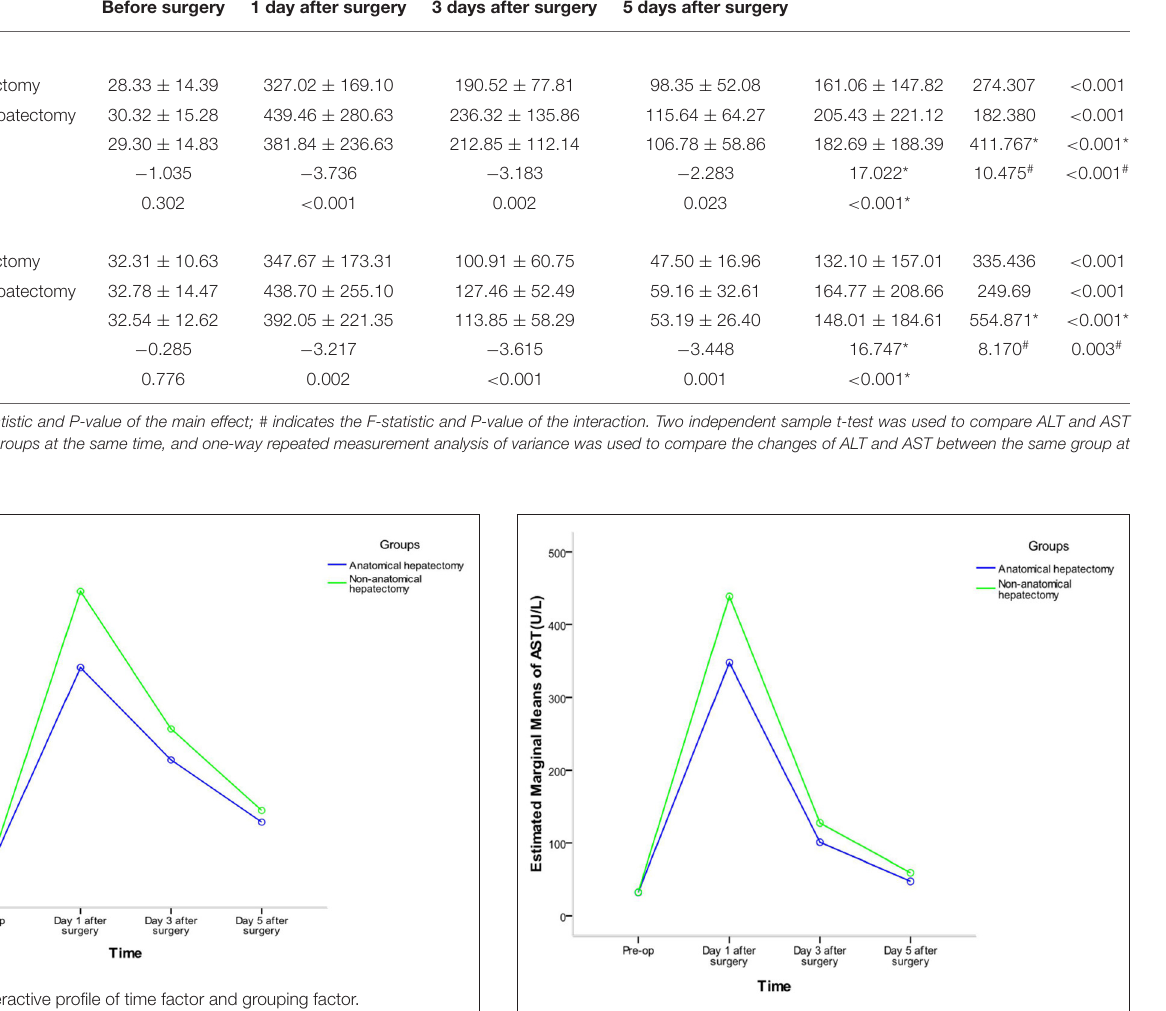
(AST) of the two groups at different times showed that there were significant differences in ALT before and after surgery in the whole sample ( F = 411.767, P < 0.001) and in each group (anatomic hepatectomy group: F = 274.307, P < 0.001; non-anatomic hepatectomy group: F = 182.380, P < 0.001). The trend of ALT in the two groups was the same: ALT was the lowest before surgery, peaked on the first day after surgery, and decreased gradually on the third and fifth days after surgery. The concentration of ALT in the anatomic hepatectomy group was significantly lower than that in the non-anatomic hepatectomy group ( F = 17.022, P < 0.001). There was no significant difference in ALT between the two groups before surgery, but it was significantly lower in the anatomic hepatectomy group at all other time points. There was an interaction effect